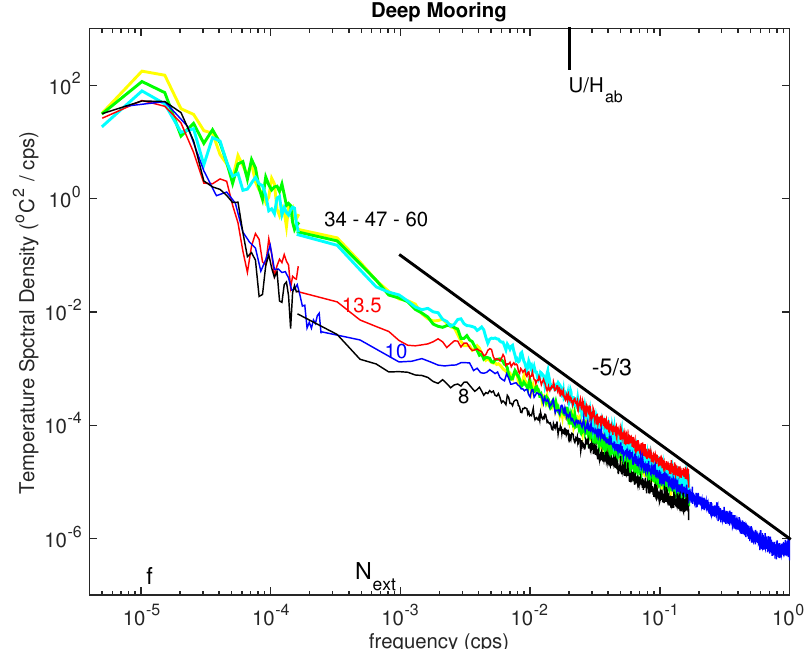
Figure 10. Spectra for the five SBE and one RBR temperature sensors. Spectra are color coded (black, blue, red, cyan, green, yellow) and labeled with their height above bottom